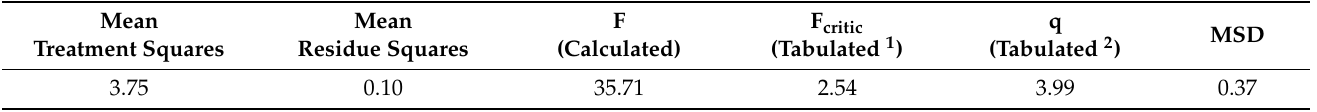
Table 6. ANOVA and Tukey’s test statistical parameters for composites deformations at